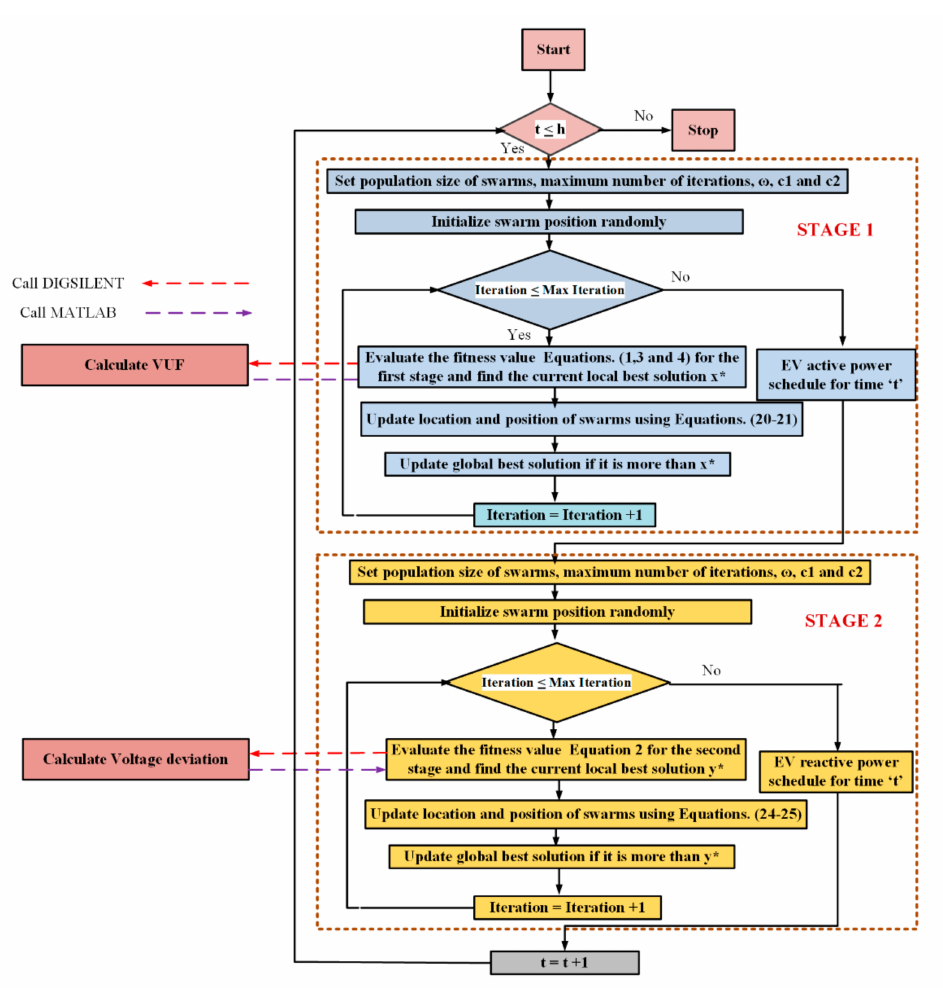
Figure 3. Application of PSO to solve the proposed